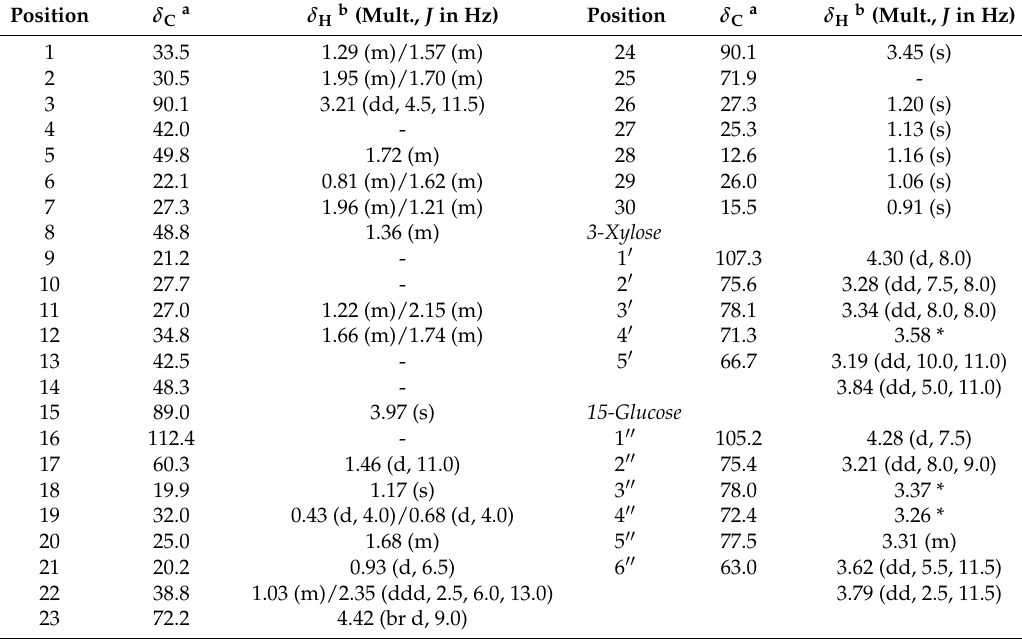
Table 3. 1 H- and 13 C-NMR Data of 6 in CD 3